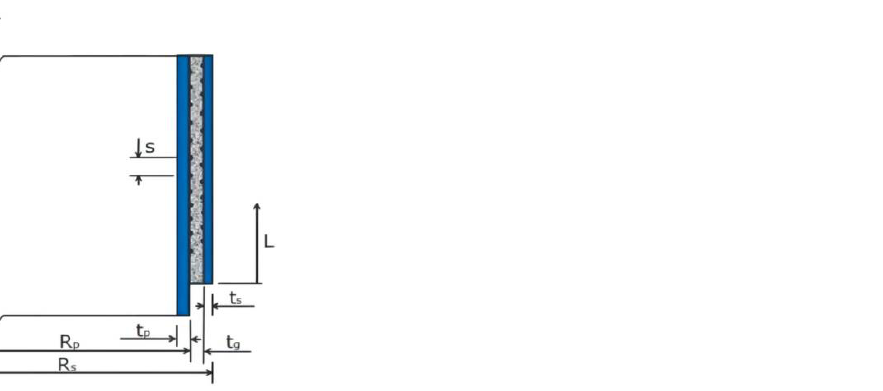
Figure 2. Diagram of grouted connecting section of single pile foundation with shear bond.